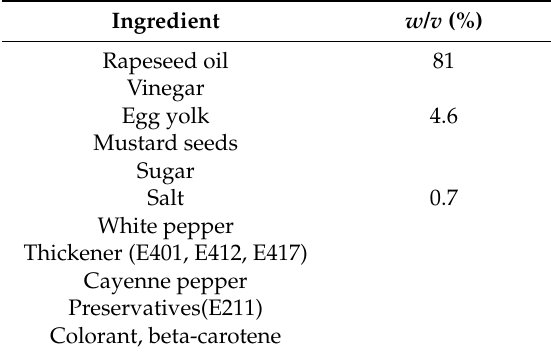
Table 2. List of ingredients in the commercial reference